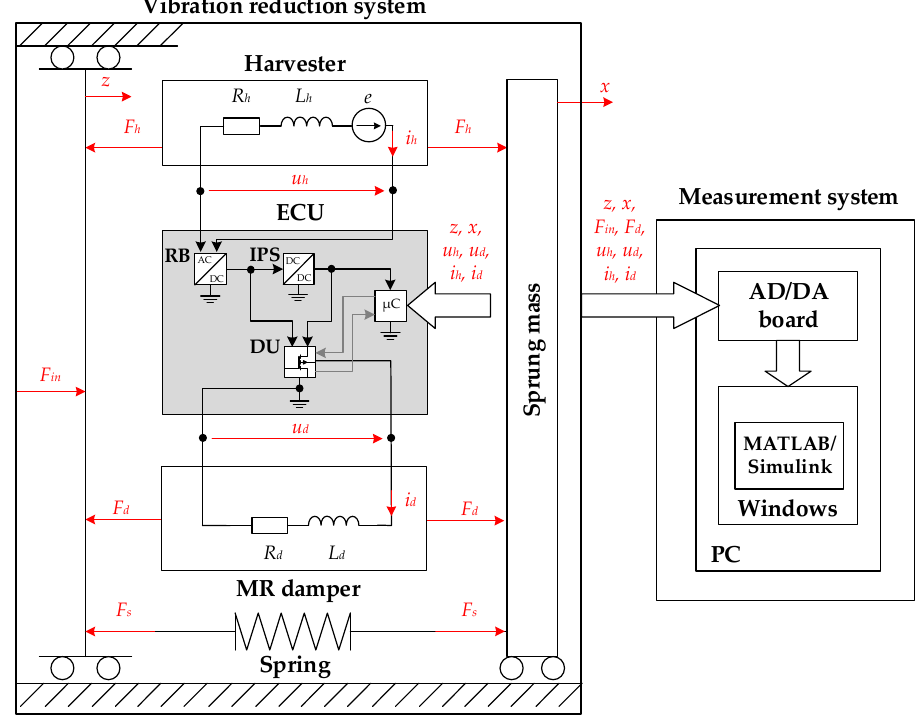
Figure 8. Schematic diagram of the experimental setup.